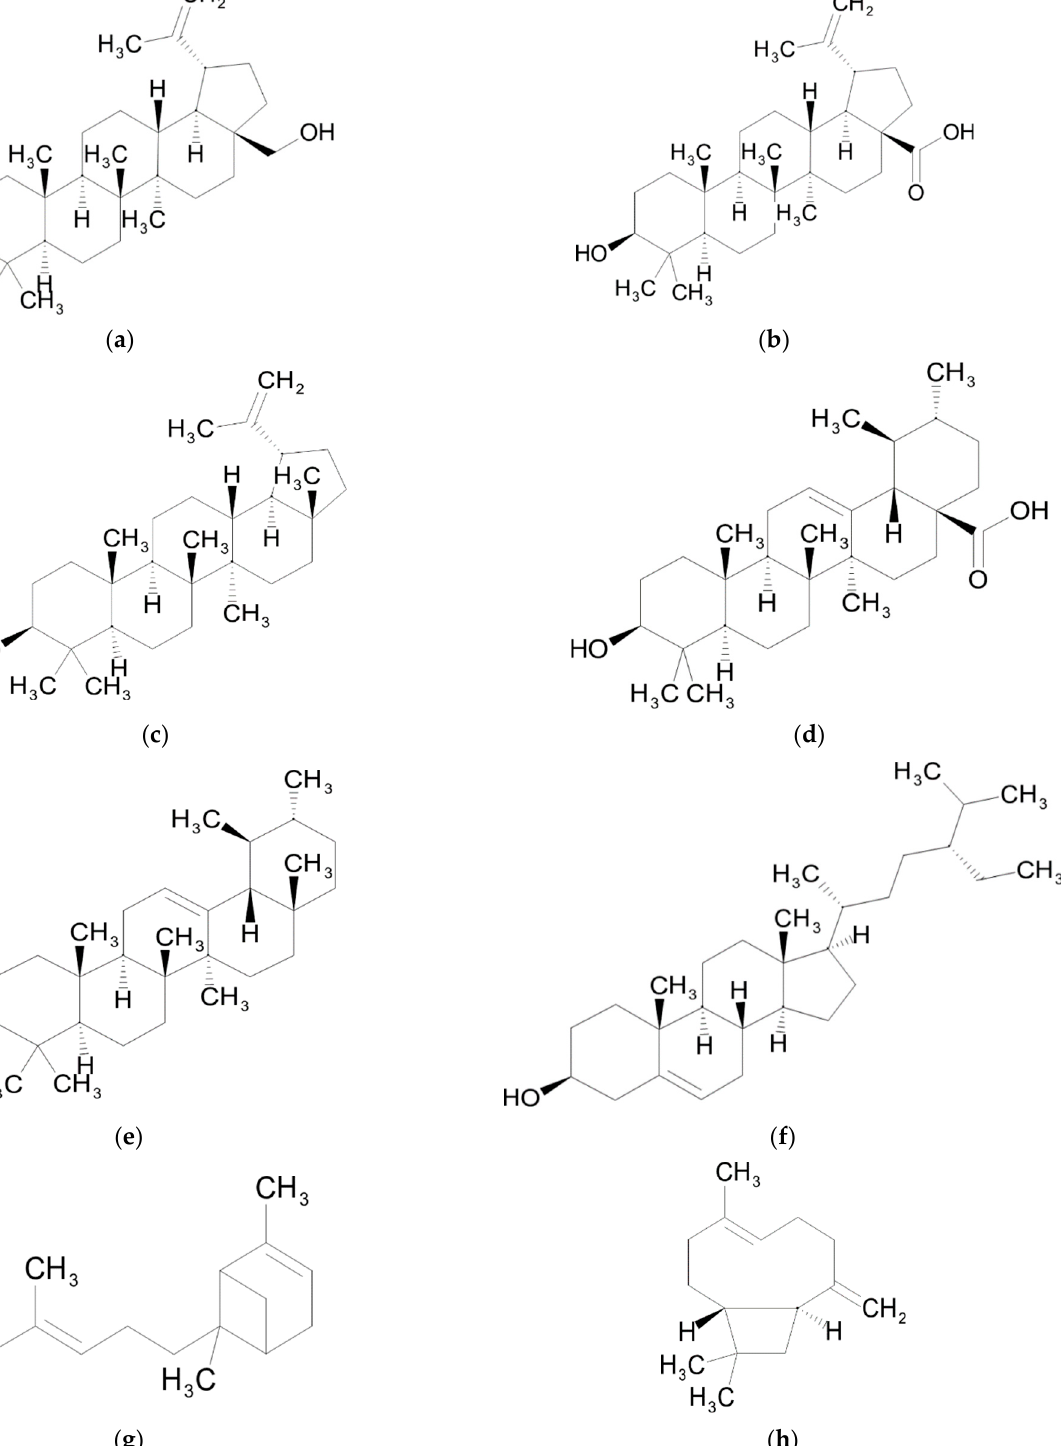
Figure 4. Chemical structures of triterpenes and sesquiterpenes from Sarraceniaceae species: ( a ) betulin; ( b ) betulinic acid; ( c ) lupeol; ( d ) ursolic acid; ( e ) α -amyrin; ( f ) β -sitosterol; ( g ) α -bergamotene; ( h ) β -caryophyllene.